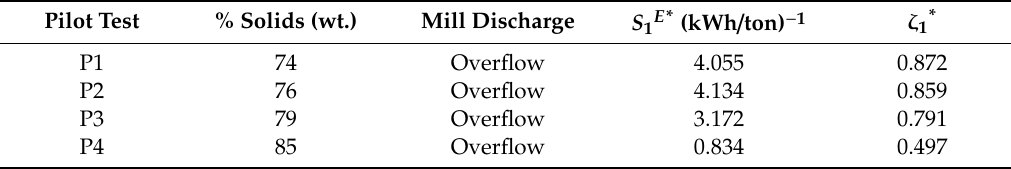
Figure 14. Comparison between the experimental and predicted size distribution for pilot test P3 considering the selection function fitted from the batch test with 80% of solids concentration and 260% of slurry filling. Table 4. Back-calculated specific selection function parameters used in plant scale mill prediction.